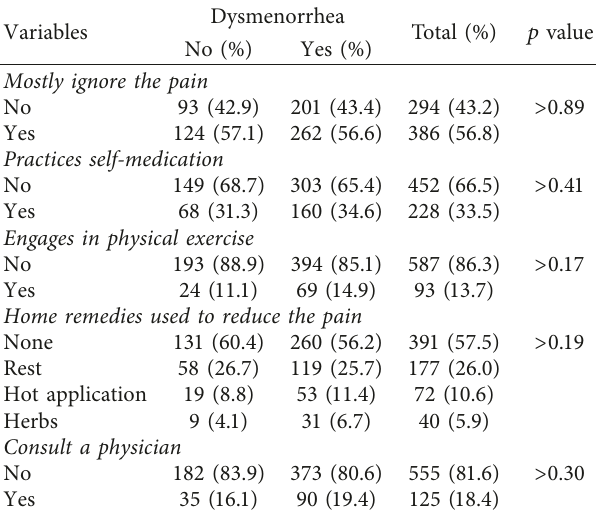
Table 4: Prevalence of mostly ignore the pain, practices self- medication, engages in physical exercise, use home remedies to reduce the pain, and consult a physician based on dysmenorrhea.